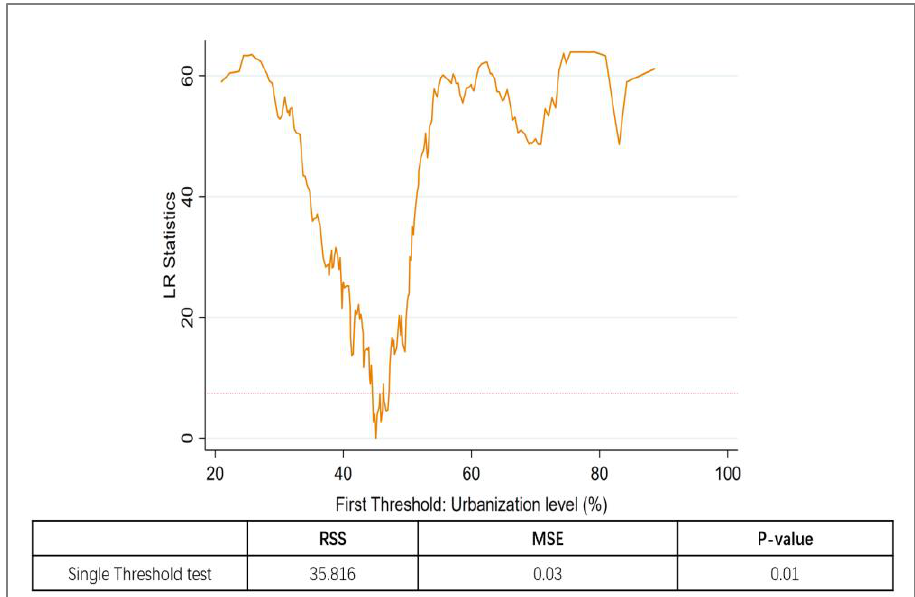
Figure 3. Threshold test for urbanization level.